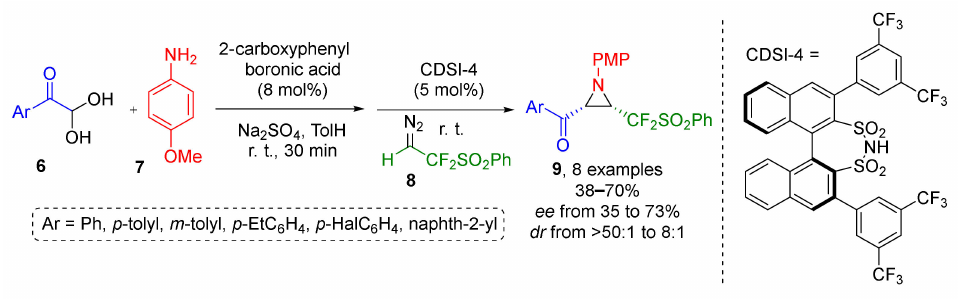
Scheme 2. Asymmetric synthesis of CF 2 -functionalized